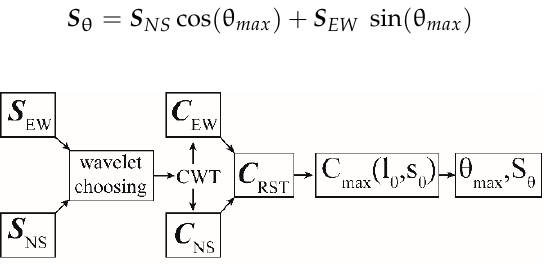
Figure 3. The procedure of identifying the horizontal direction θ max , and the corresponding seismic signal S θ .